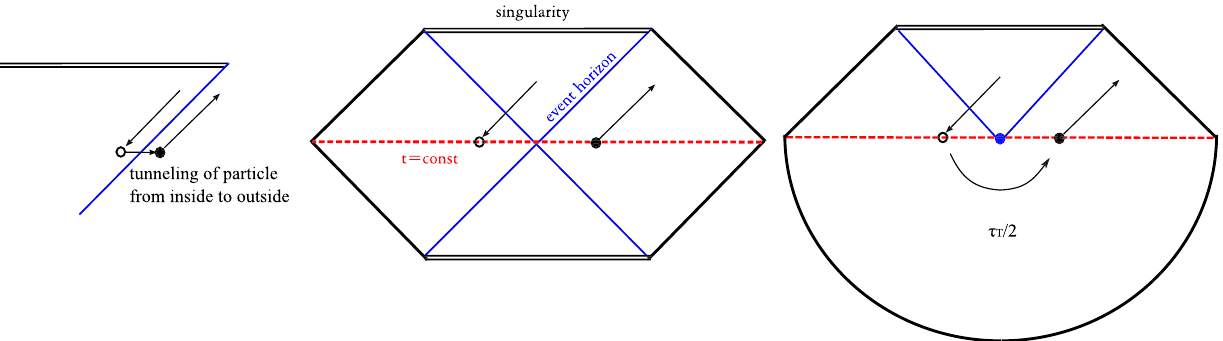
Fig. 7 Left: the Parikh–Wilczek method describes tunneling from inside to outside the event horizon. Middle: the important contribution is tunneling from left (white dot) to right side (black dot) of the whole causal structure. Right: two particles can be connected by the Euclidean manifold outside the